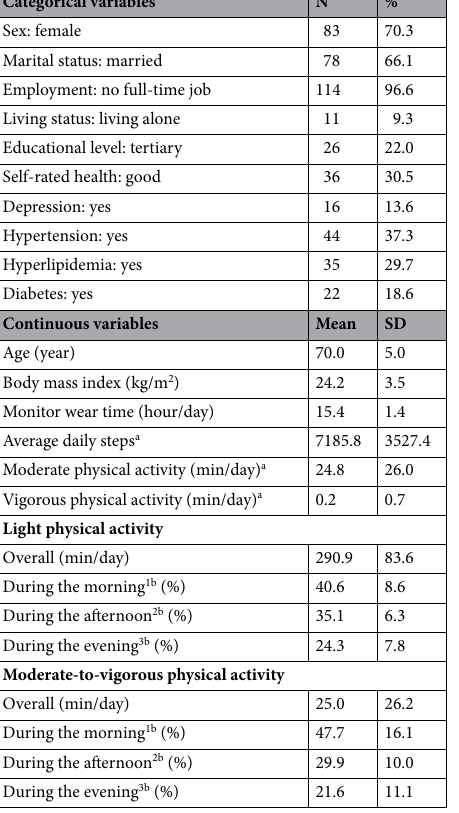
Table 1. Participants’ characteristics (n = 118). SD: standard deviation. a These variables were not considered as covariates. b The sum of percentages of light physical activity and MVPA during the morning, afternoon, and evening may be not 100.0% because each percentage of time interval was an average of 118 participants. 1 During the morning: 06:01–12:00. 2 During the afternoon: 12:01–18:00. 3 During the evening: